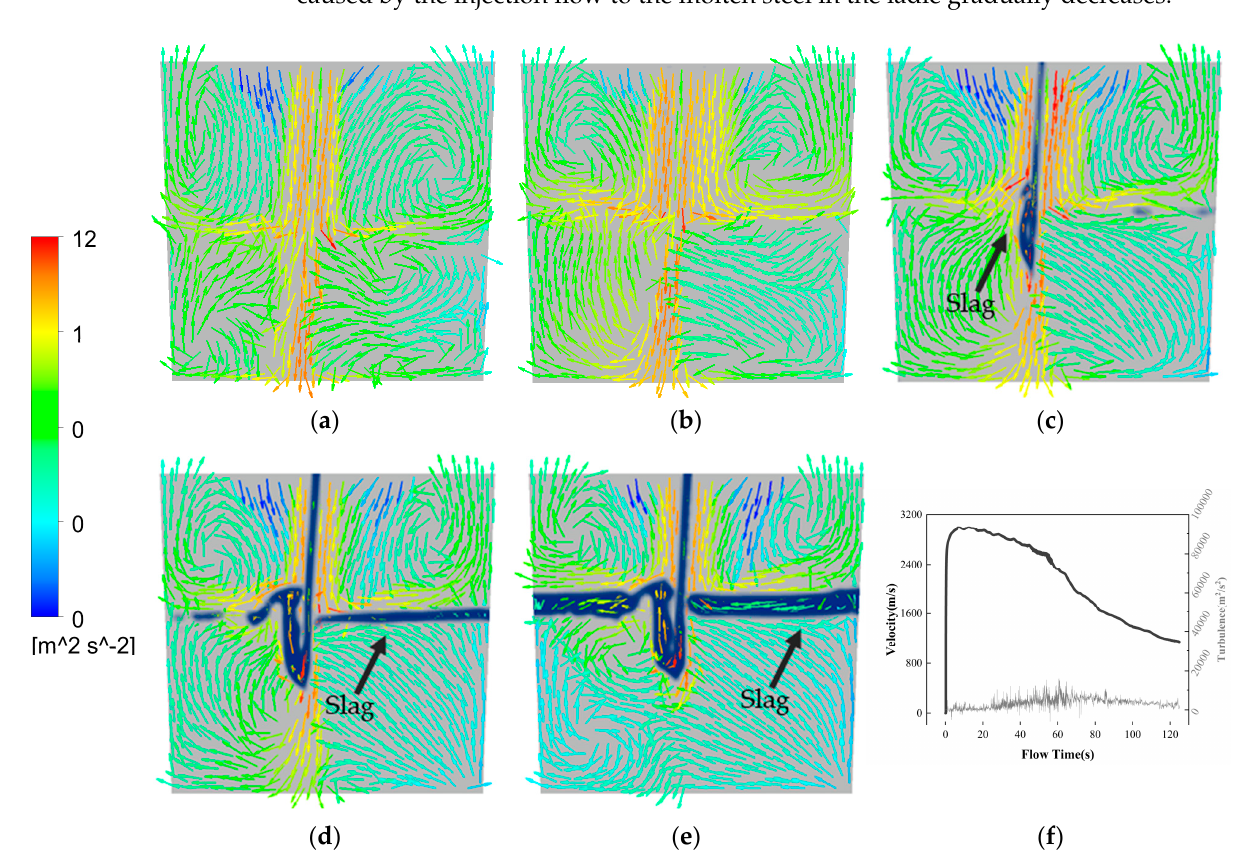
Figure 4. Turbulent flow distribution diagram in the ladle at ( a ) 20 s; ( b ) 50 s; ( c ) 70 s; ( d ) 90 s; ( e ) 125 s during steel tapping when the converter is at 90° and ( f ) velocity vector and turbulence intensity distribution.